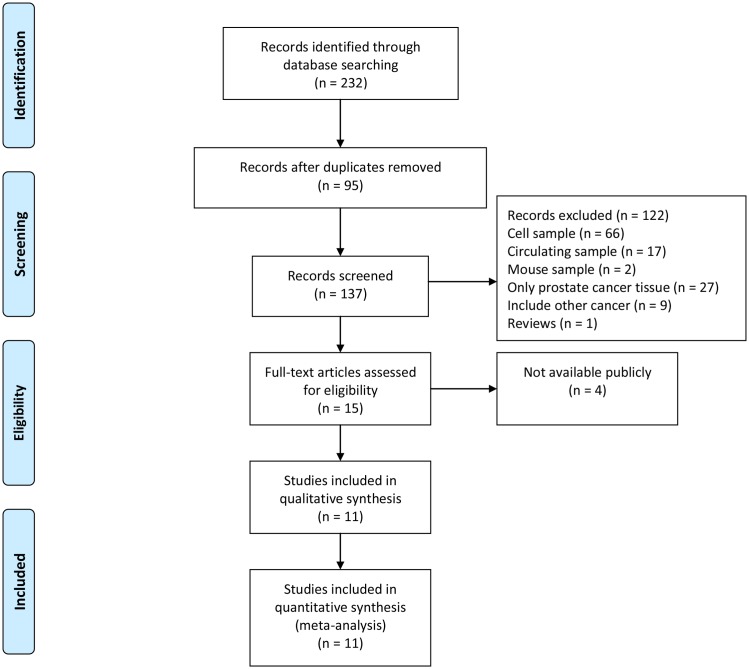
Searching strategy.